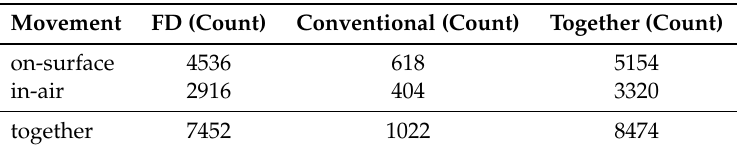
Table 4. Feature sets